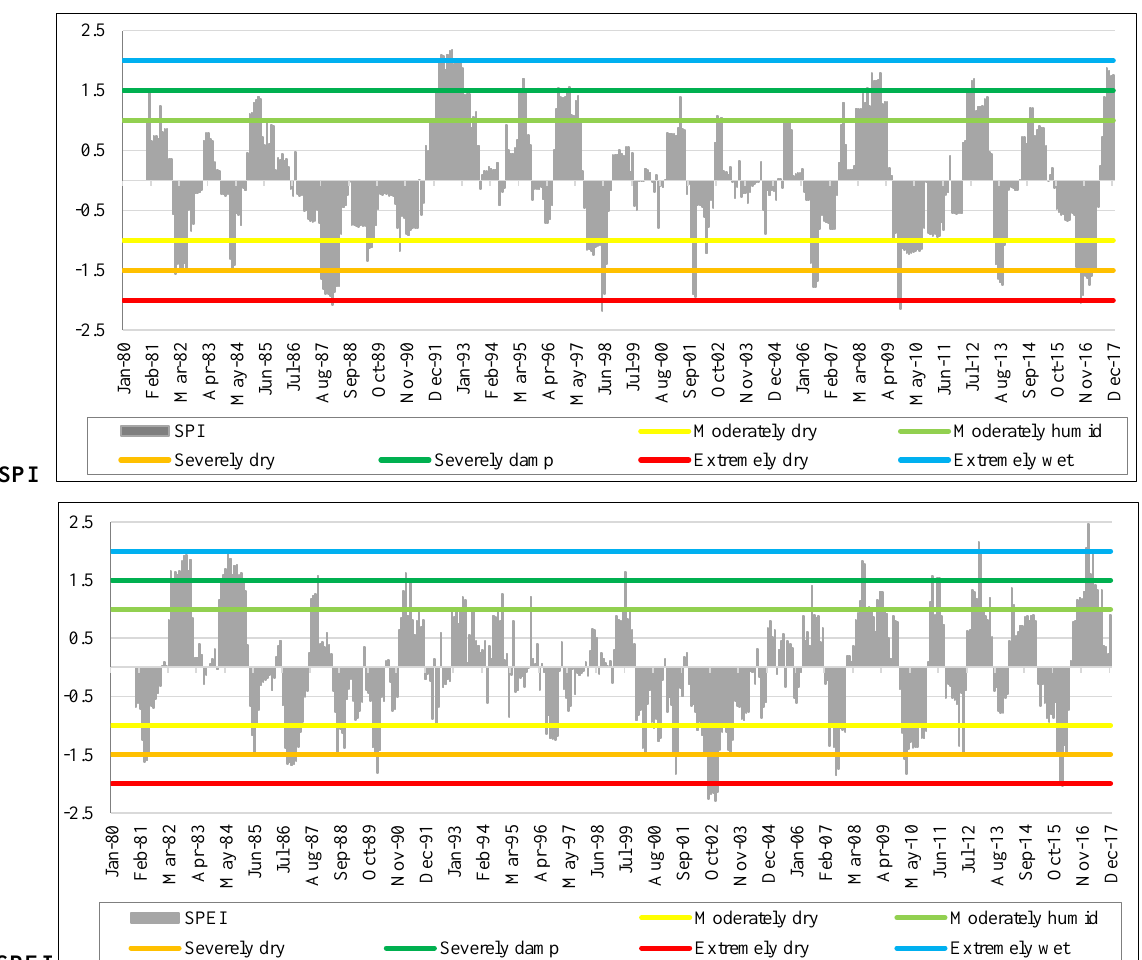
Figure 2. Average SPI (left) and SPEI (right) values for stations in the Senegal River Valley area (coloured lines indicate critical index values under dry and wet